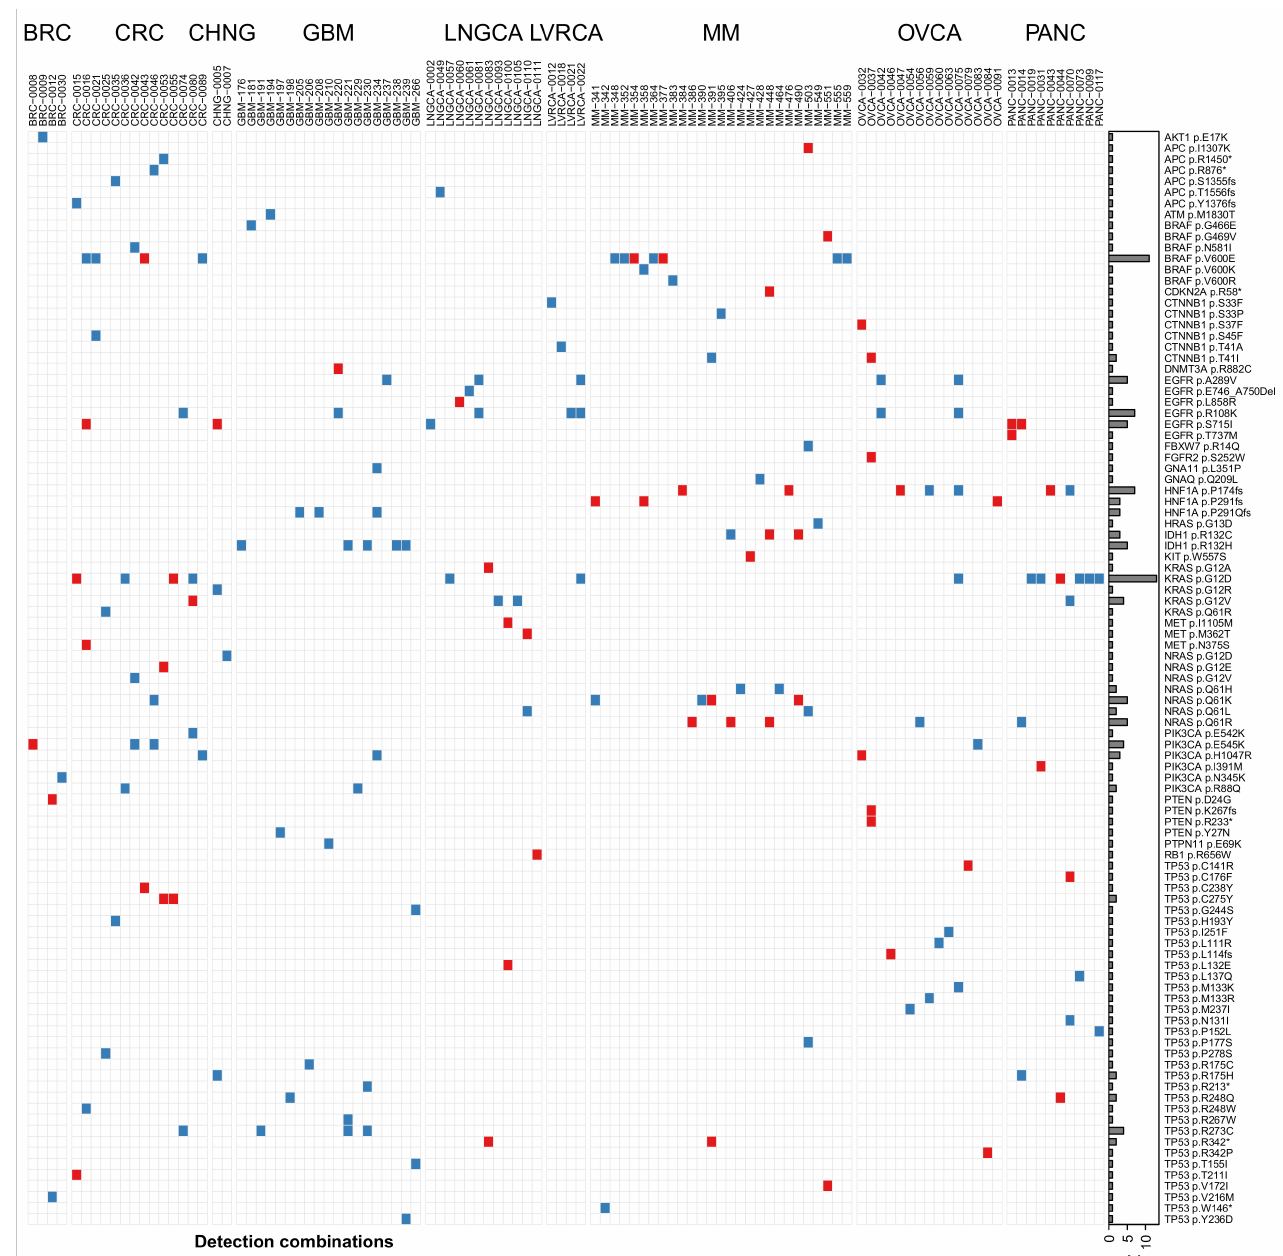
Figure 1. A total of 107 human samples investigated are listed in the X -axis, with 99 mutations detected listed in the Y -axis. The pairs with circulating tumor DNA (ctDNA) not detectable in the blood are indicated in blue, and the pairs with ctDNA detectable in the blood are indicated in red. Tumor mutations were identified by a CLIA test (such as Foundation One) and/or by our in-house MiSeq